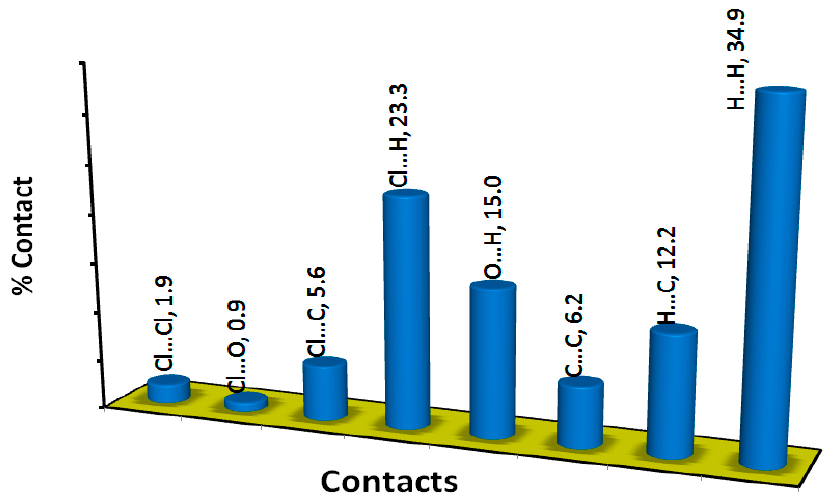
Figure 5. Percentages and intermolecular interaction summary for 5 .